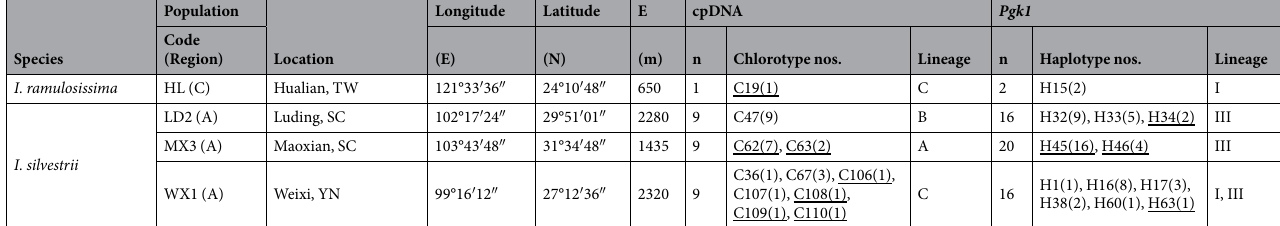
relationships, indicating radiative diversification. The haplotype network showed the star phylogeny, and most cpDNA haplotypes were arranged as a radiative phylogenetic tree relative to the central ones, e.g. C67, C36, C24, C75, C74 and C8 (Fig. 1). The dating analyses under different substitution rates suggested that the common ancestor of the I. bungeana complex originated during the Pliocene, and those of clades A, B and C in the Pliocene to early Pleistocene. Diversification of haplotypes in clade C, which comprised almost all the chlorotypes, was estimated to have occurred before the LGM (see Supplementary Table S1). Pgk1 variation and haplotype structure. The alignment of Pgk1 across the 434 individuals was 792 bp, containing 58 substitutions and 8 indels (4 ‒ 28 bp). These polymorphisms defined 68 haplotypes, with 42 (61.8%) haplotypes unique to a single population (Table 1). The most common haplotypes H2 and H6 occurred in 20 (39.2%) and 13 (25.7%) populations, respectively. Total haplotype ( H d ) and nucleotide ( π ) diversity of the Pgk1 was 0.927 and 0.0106, respectively. Among the 51 populations surveyed, five were fixed for a single haplotype, and the remaining ones were polymorphic (Table 1; Fig. 3). Nuclear ( Pgk1 ) haplotypes clustered into three clades (Fig. 4). The basal clade comprised the haplotypes occur- ring in the HMR and southern China, and clade II included H26 and H27 that were restricted to a population of I. amblyantha (southern China: JZ), while the clade III comprised the remaining haplotypes that occurred through- out the whole distribution areas of I. bungeana complex. The haplotype network showed the same star phylogeny with most haplotypes relative to the central ones (e.g. H1, H2, H16 and H17) which occurred at a high frequency (Fig. 4b). The crown age of the I. bungeana complex estimated from Pgk1 was 1.47 (95% HPD: 0.75 ‒ 2.37) Ma. The common ancestors of clades I, II and III were estimated to have occurred 0.67 (95% HPD: 0.26 ‒ 1.28) Ma, 0.35 (95% HPD: 0.01 ‒ 0.93) Ma and 0.98 (95% HPD: 0.51 ‒ 1.66) Ma (Table S3), respectively. Genetic differentiation. The SAMOVA analysis failed to uncover any reliable population genetic group in either the cpDNA or nuclear datasets (see Supplementary Fig. S1). We therefore divided all the populations into three groups according to the classical phytogeographic boundaries defined by Wu & Wu 28 : (A) Hengduan Mountains region (HMR), (B) Northern China, (C) Southern China (see Figs 1 and 2). The level of total genetic diversity H T (cpDNA: 0.991; Pgk1 : 0.939) across the overall populations was much higher than the average within-population gene diversity H S (Table 2). The highest genetic diversity occurred in southern China (cpDNA: 0.982; Pgk1 : 0.922), in accordance with the occurrence of the most divergent haplotypes in this region (Figs 1 and 2). For both cpDNA and Pgk1 datasets, a significantly larger N ST than G ST value across overall populations was detected (Table 2), indicating the presence of a significant phylogeographic structure. Hierarchical AMOVA revealed low levels of regional and species differentiation (Table 3; see Supplementary Figs S2–S5). Variations among regions accounted for 5.26% and 23.53% of the total genetic variation for cpDNA and Pgk1 datasets, respectively. Populations in the HMR and southern China showed significantly higher varia- tion among populations than within populations, while extremely lower differentiation among populations than within populations in northern China (Table 3). The highest level of genetic differentiation among populations (cpDNA: PV = 77.54%, F ST = 0.775; Pgk1 : PV = 86.74%, F ST = 0.867) was observed in the HMR, which was con- sistent with the significantly higher G ST values than in other regions (Table 3). Complex and heterogeneous cli- mate and topography may serve as a favorable condition for isolation, drift and barriers of gene flow in the HMR. When each species was analyzed separately, differences among species explained 7.56% ( F CT = 0.076) and 4.76% ( F CT = 0.048), those among populations within species 53.33 ( F SC = 0.577) and 76.12% ( F SC = 0.799), and those within populations 39.11% ( F ST = 0.609) and 19.11% ( F ST = 0.809) of the total cpDNA and nuclear DNA genetic variation, respectively (Table 3). Tests of demographic expansion. Under a model of population expansion, the major clades identified in the cpDNA (clade A, B and C) and Pgk1 (clade I, II and III) phylogeny displayed a bimodal or multimodal mismatch distribution (Fig. S6). However, none (except cpDNA clade A and Pgk1 clade I) of the statistical com- parisons between these observed distributions and simulated ones under a sudden expansion model significantly rejected the expansion model ( P values > 0.05 based on SSD and H Rag , Table 4). Nonsignificant SSD and rag- gedness index, as well as a significant large negative F S (C: F S = − 24.002, P < 0.001; III: F S = − 21.123, P <